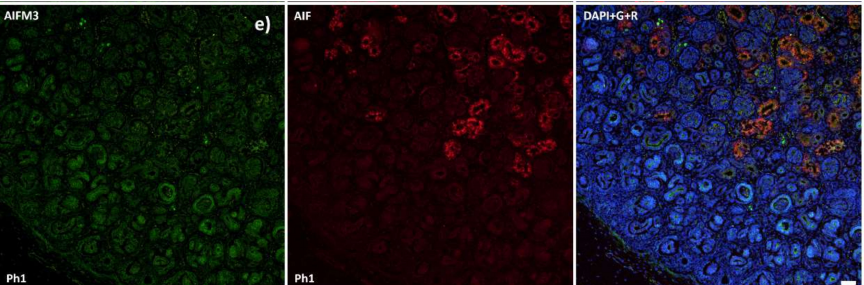
Figure 1. Immunofluorescence staining of human fetal ( a , c , d ) and postnatal ( b ) kidneys with the AIFM3 (green) and AIF (red) markers and their co-expression with DAPI nuclear staining. Ex- pression of AIFM3 and AIF (arrows), glomeruli (G), proximal convoluted (PCT), distal convoluted tubules (DCT), immature glomeruli (IG), and S-shaped bodies (SSB). Co-expression of AIF and AIFM3 (arrows) can be seen on merged photographs as yellow. Images a, b, c and d were taken on magnification 40 × , while e was taken on 10 × . Scale bar is 40 µ m. ( a ) The first three phases of kidney development mostly correspond regarding intensity and localization of AIFM3 thus a representative image was selected from Ph2. Individual cells of the DCTs exhibited a strong signal intensity. ( b ) Ph4 prenatal and Ph4 1M exhibited markedly more positive area percentage compared with the first three phase. Unlike the previous phases, a weak positive signal was detected in the glomeruli. Not much difference was observed regarding localization and signal intensity between the postnatal phases and the prenatal Ph4. ( c ) Ph4 1.5Y postnatal has significantly less positive area of tissue than both Ph4 pre and Ph4 1M, but the glomeruli displayed markedly more positive cells. ( d , e ) The developing structures of the nephron were devoid of AIF signal in all phases where they were present, unlike AIFM3 where they were all markedly more positive than the mature structures.